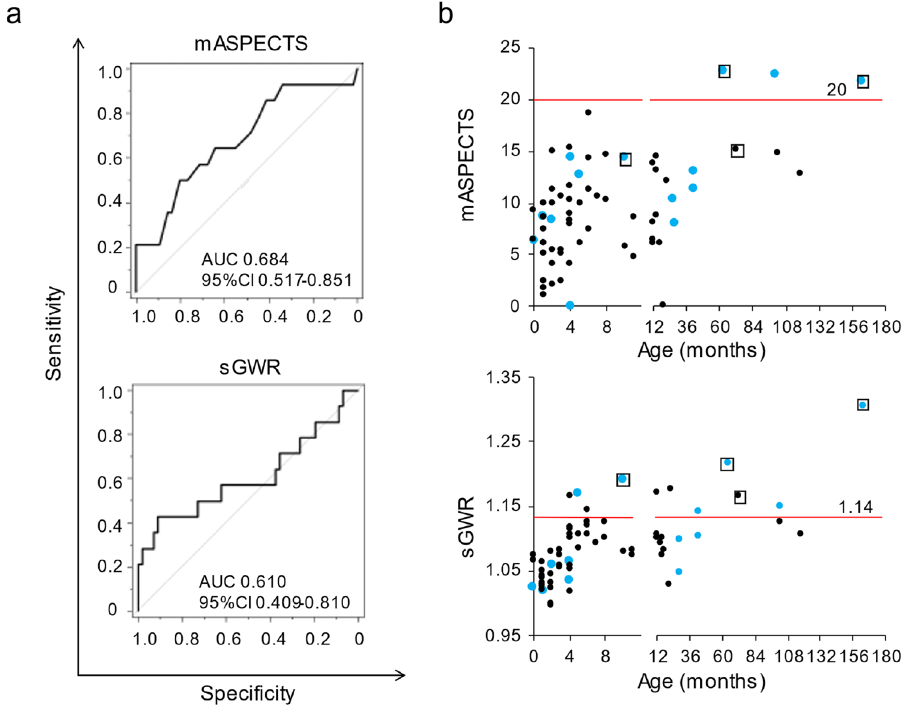
Figure 4. Prognostic values of the mASPECTS and sGWR for 30-day survivors. ( a ) Receiver operating characteristic (ROC) curves for the mASPECTS (upper) and sGWR (lower). No significant differences in the areas under the ROC curve between the 2 systems are observed ( p = 0.32). ( b ) The mASPECTS (upper) and sGWR (lower) scores against the age of patients at CA. More survivors (blue) than non-survivors (black) are plotted above the cut-off lines (mASPECTS ≥ 20 and sGWR ≥ 1.14). Fisher’s exact tests (mASPECTS; p = 0.007, sGWR; p = 0.006). Open squares denote the four patients with shockable rhythm (ventricular tachycardia and/or